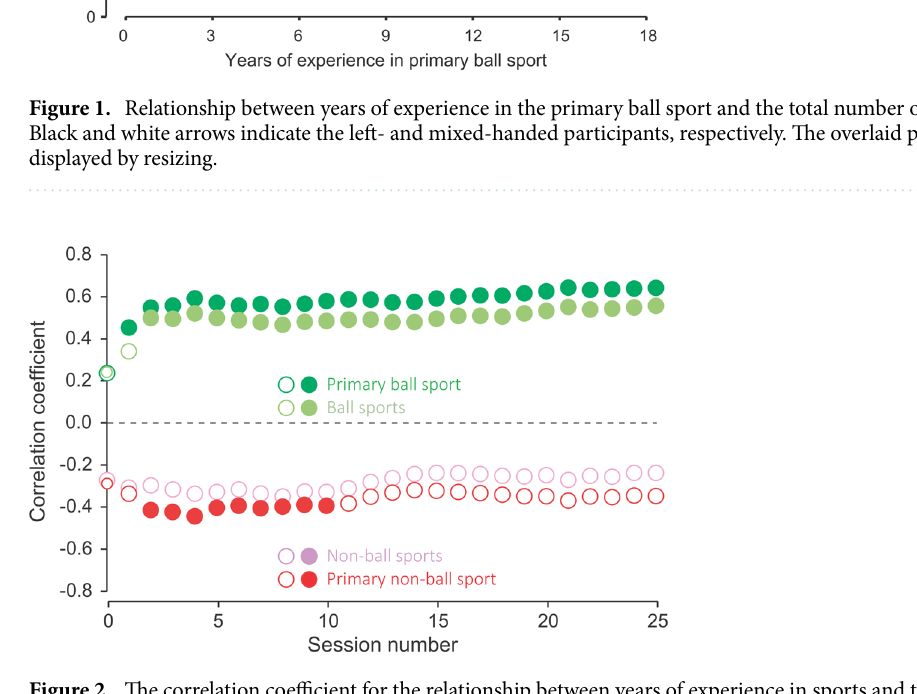
Figure 2. The correlation coefficient for the relationship between years of experience in sports and the total number of catches in each session. Closed and open circles indicate significant and non-significant relationships, respectively. Session zero represents the initial value before the practice session. The overlaid plots can be displayed by